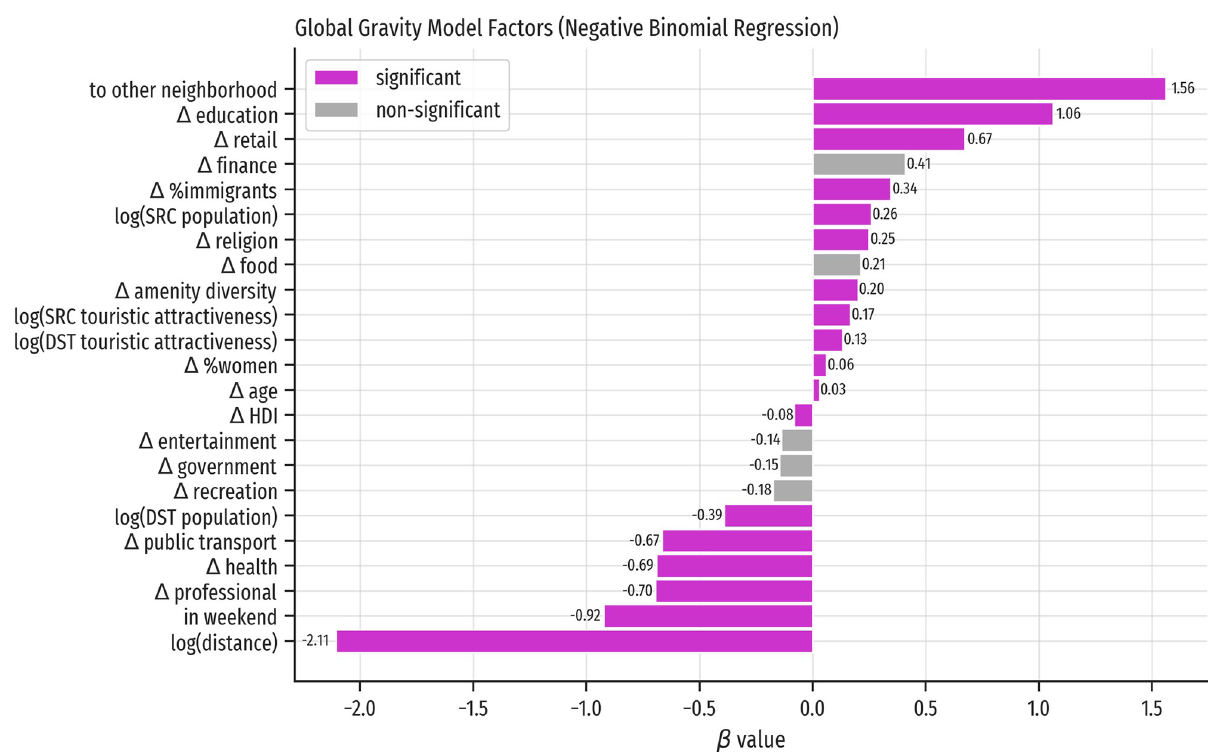
Fig 4. Global gravity model factors. Positive values indicate that the corresponding factor is associated with an increase in flows from one neighborhood to another.